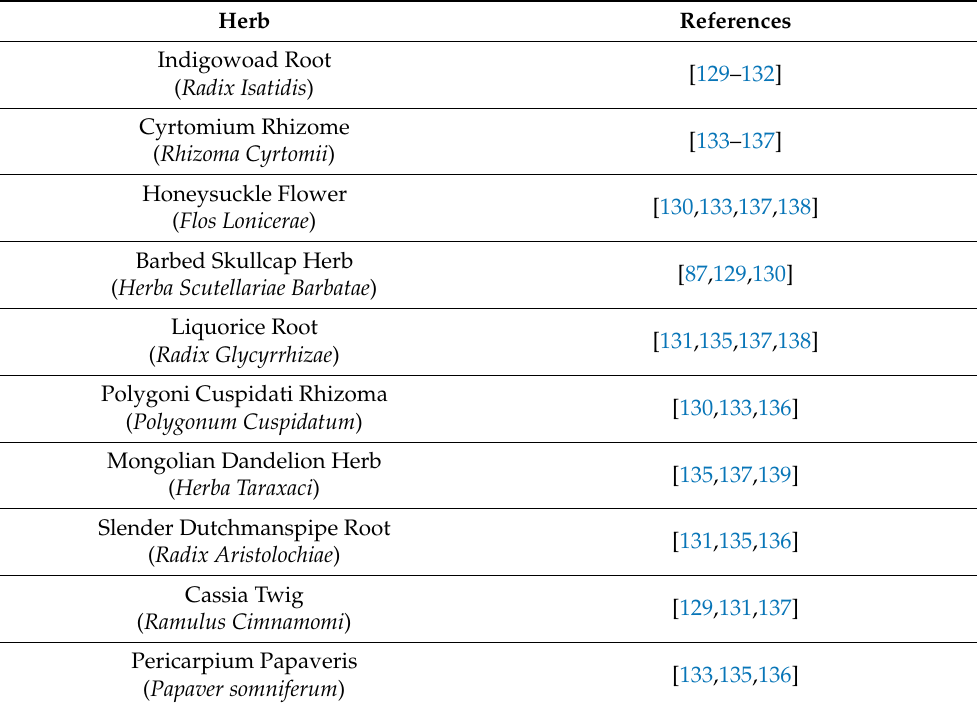
Table 2. Chinese herbal medicines reported to be effective in controlling sacbrood disease in A. cerana in